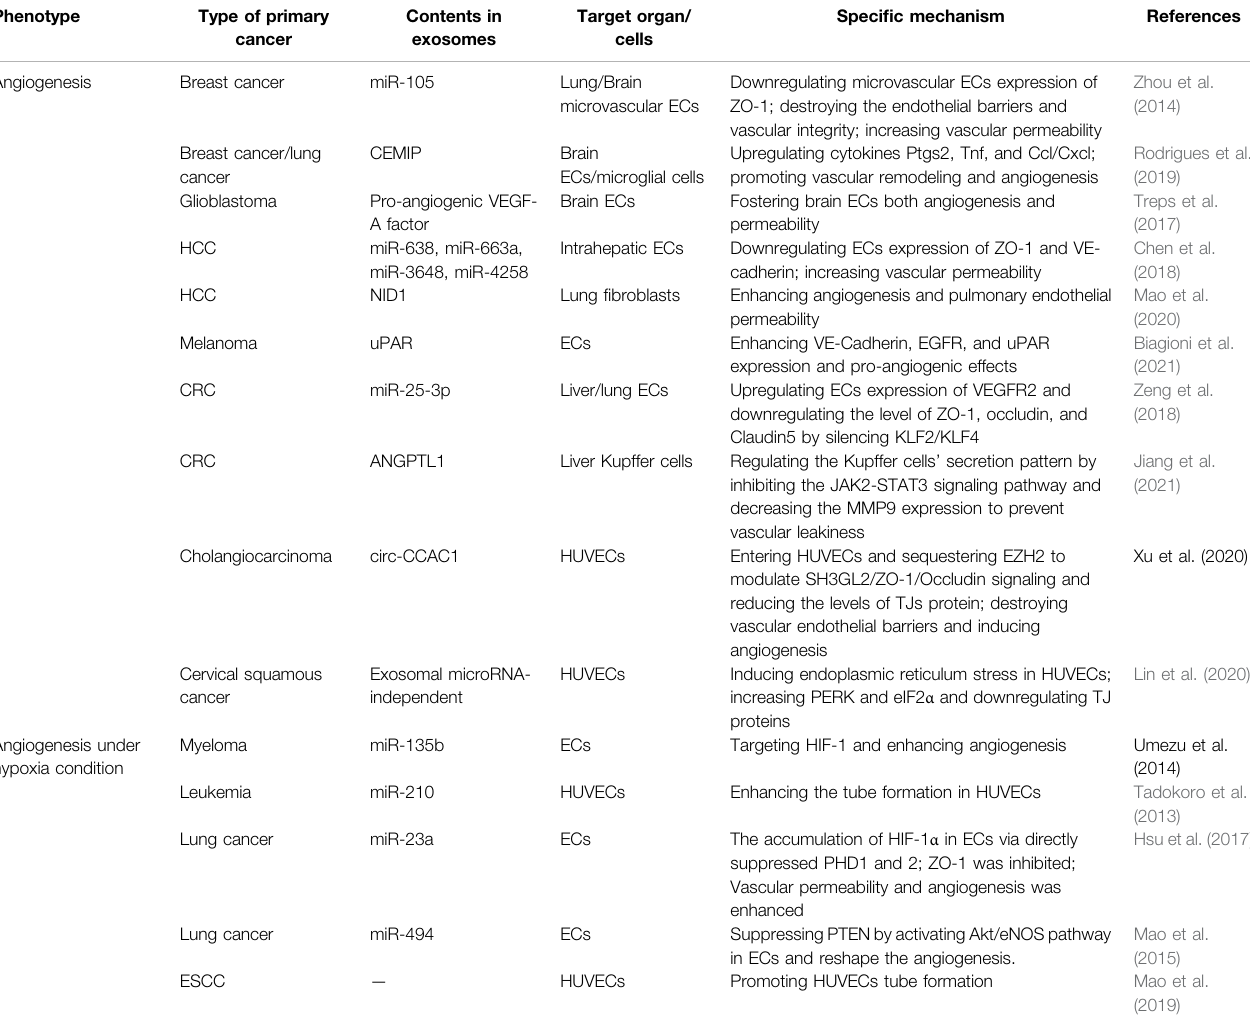
TABLE 2 | The role of exosomes in angiogenesis and vascular